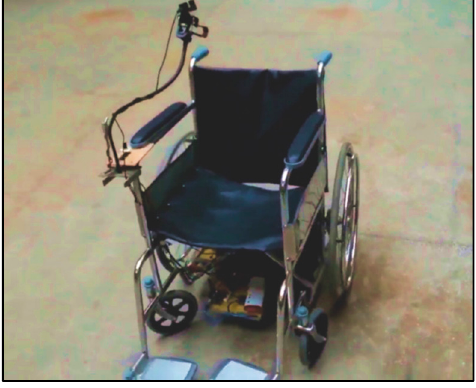
Figure 8. Wheelchair model with all essential components installed appropriately.